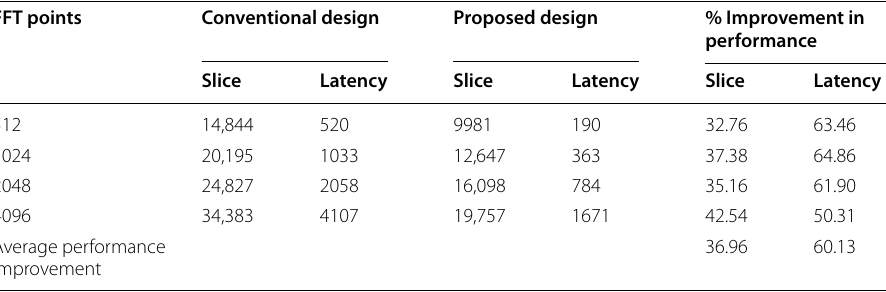
Table 1 Resource utilization and performance of the proposed architecture FFT